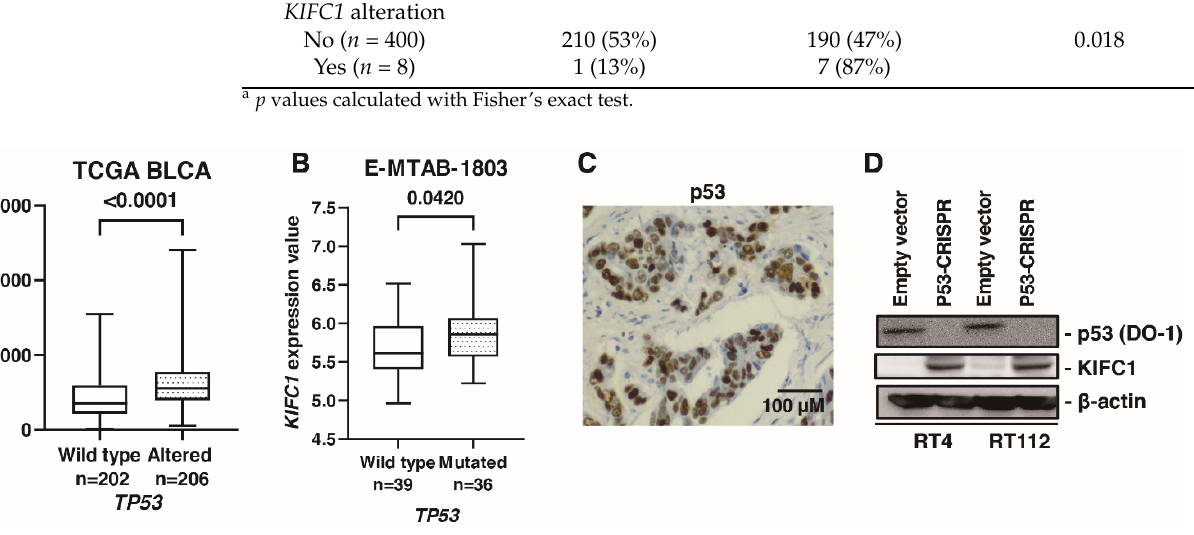
Figure 6. KIFC1 is regulated by p53 in bladder cancer (BC). ( A ) Box plot of KIFC1 expression in wild-type and altered TP53 in TCGA BLCA. ( B ) Box plot of KIFC1 expression in wild-type and mutated TP53 in E-MTAB-1803. ( C ) Representative immunohistochemical images of p53 overexpression in BC. Original magnification: 400 × . ( D ) Western blotting of p53 (DO-1) and KIFC1 in RT4 and RT112 cells transfected with empty vector or p53-CRISPR. β -Actin was used as a loading control. Table 6. Relationship between KIFC1 expression and p53 in the 58 bladder cancer from Hiroshima